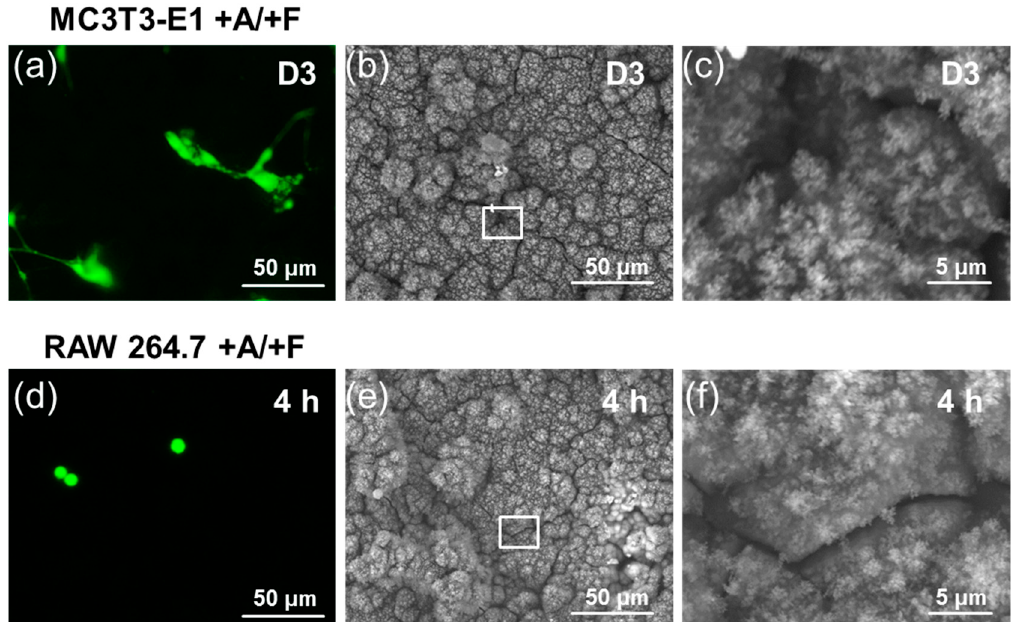
Figure A3. SEM imaging of (+A/+F)-bCaP(24 h)-PEM before and after incubation in media only, no cells. ( a , b ) AntiA-bCaP(24 h)-PEM-FGF2 before incubation in culture medium (0 h); ( c , d ) low and high magnification of +A/+F AntiA-bCaP(24 h)-PEM-FGF2 incubated in culture medium for 4 h; and ( e , f ) low and high magnification of +A/+F AntiA-bCaP(24 h)-PEM-FGF2 incubated in culture medium for three days. Blue circles in ( a , c and e ) highlight other openings between crystal junctions that are similar to those selected within the white boxes for higher magnification in the ( b , d and f ).